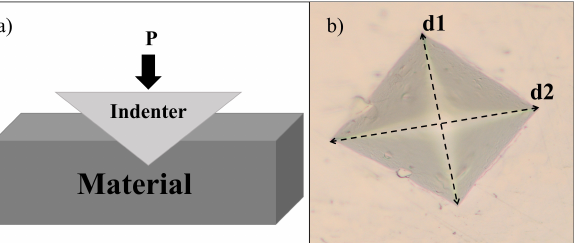
Figure 1. Indentation process of a material sample. ( a ) force applied with an indenter to the material; ( b ) indentation